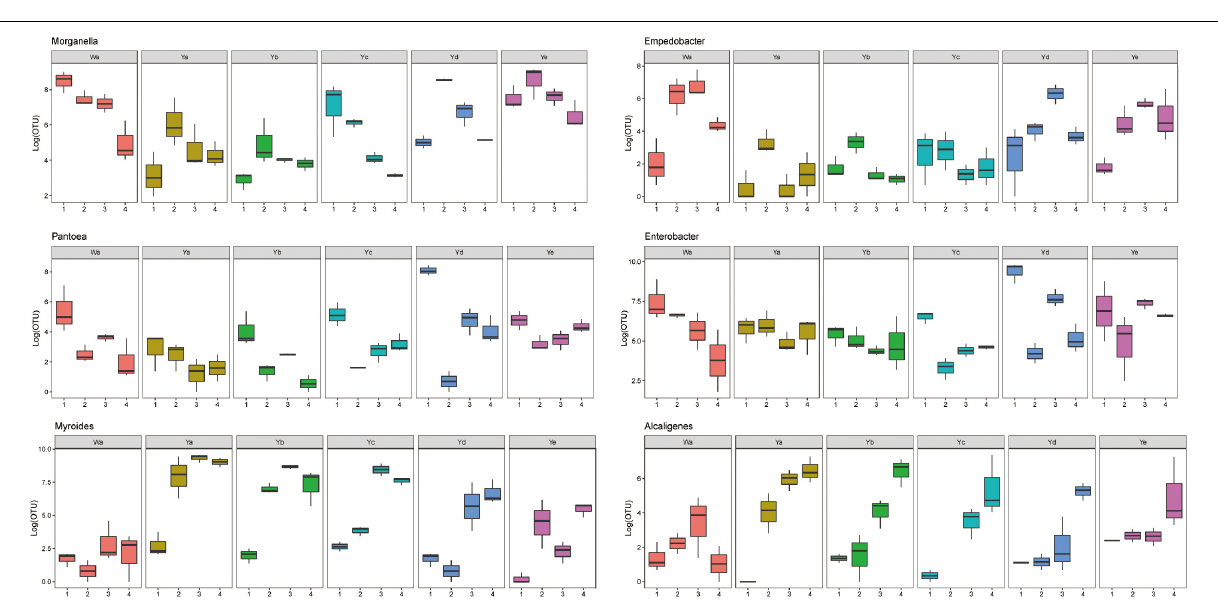
FIGURE 5 | Dynamic variation of OTU number of key bacteria in different groups fed with different dilution concentrations of P. aeruginosa . Wa, Ya, Yb, Yc, Yd, and Ye represent housefly larvae samples fed diets with sterile water, P. aeruginosa stock solution, and the stock solution diluted 10 2 , 10 4 , 10 6 , and 10 8 fold,